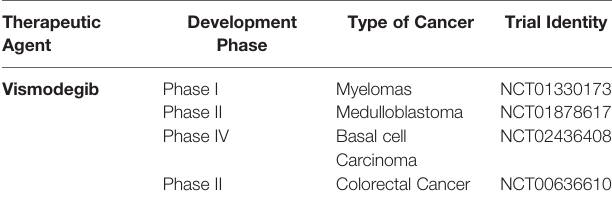
TABLE 3 | Representation Hh signaling inhibitor under clinical